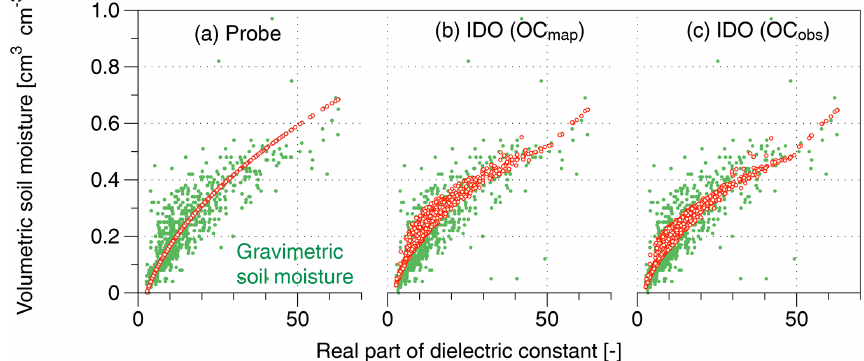
Figure 5. Scatter plot between probe measurements of the real part of the dielectric constant ( x axis) and volumetric soil moisture ( y axis) measured by the gravimetric method (green dots in a–c ), Seyfried model (red dots in a ), the IDO with SOM taken from SoilGrid250m (Hengl et al., 2017) (red dots in b ), and the IDO using OC measured during SMAPVEX12 (Manns and Berg, 2014) (red dots in c ).